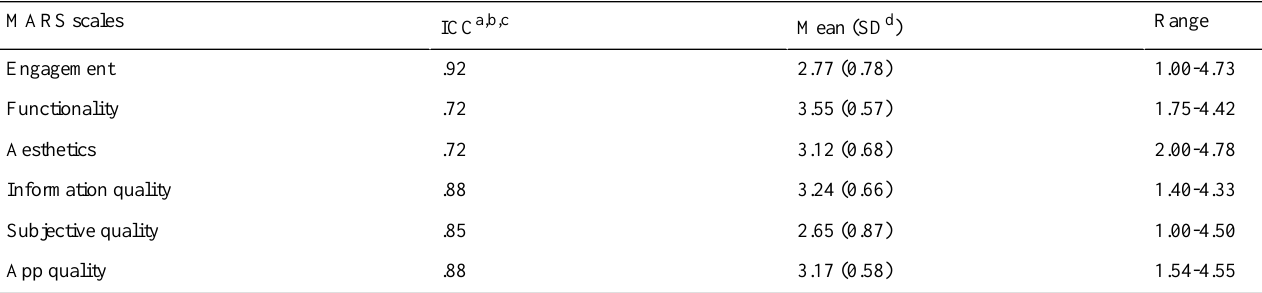
Table 2. Descriptive results of Mobile Application Rating Scale (MARS) scores